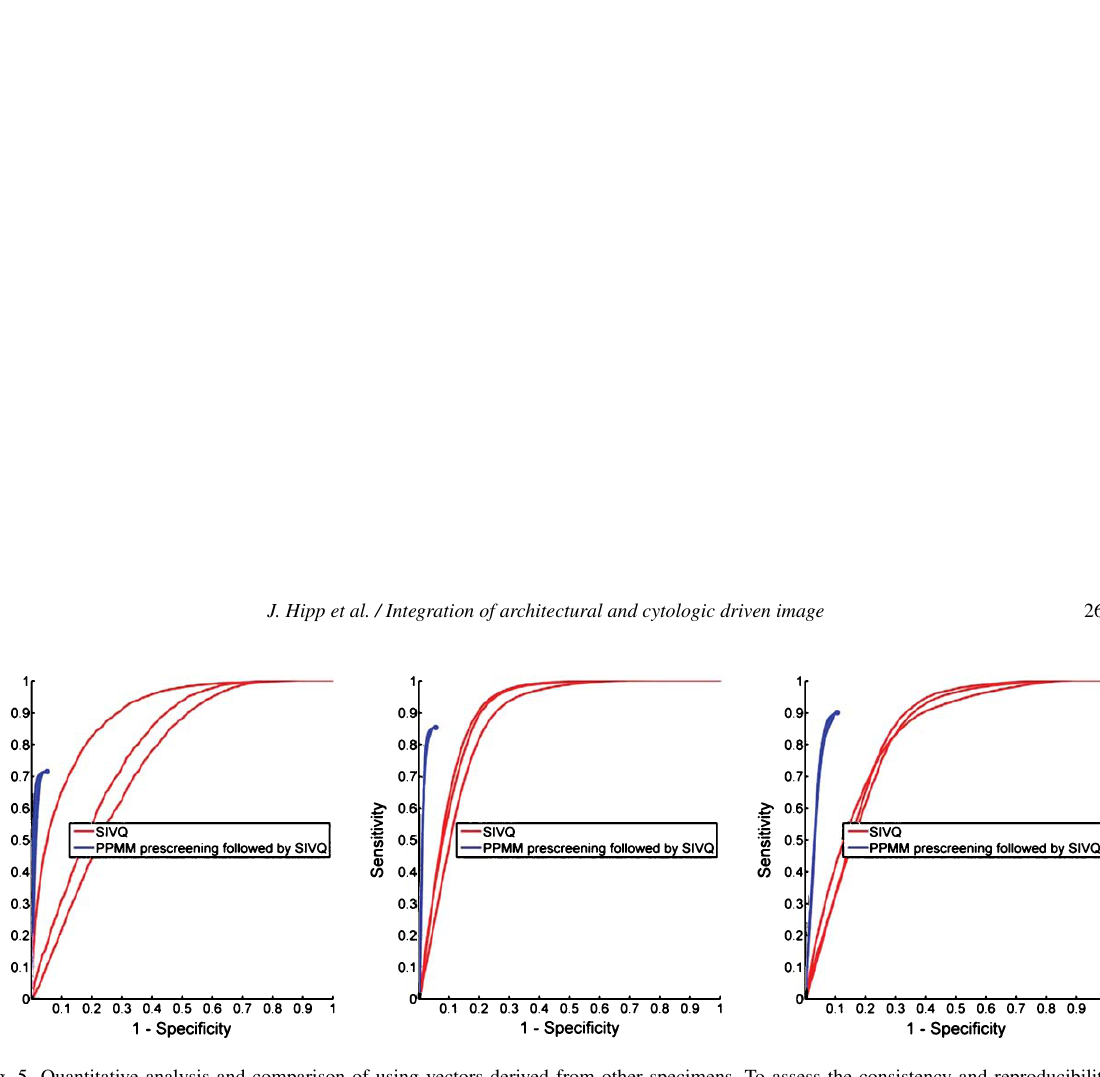
Fig. 5. Quantitative analysis and comparison of using vectors derived from other specimens. To assess the consistency and reproducibility of using vectors derived from separate specimens, each of the specimens were then analyzed with the three ring vectors from above. The red curves represent the ROC curves from just the SIVQ analysis. Since these vectors were designed to identify epithelium, and were of different ring sizes (4–7 pixels in diameter), their performance variability was expected to identify benign and malignant epithelium. PPMM- SIVQ was used to analyze the three cases for each of the three vectors and their ROC curves (in blue) are shown above (left correspond to specimen#1,middlespecimen#2,andrightspecimen#3).ThePPMM-SIVQcurvesshowaconsistentandreproducibleincreaseinperformance independent of which vector was used compared to SIVQ alone. As mentioned previously, since PPMM-SIVQ applies SVIQ only to a subset of the tissue (which is determined by PPMM), its performance is bounded by the maximum sensitivity and minimal specificity established by this subset. This explains why the PPMM-SIVQ ROC curves terminate abruptly. (Colours are visible in the online version of the article;